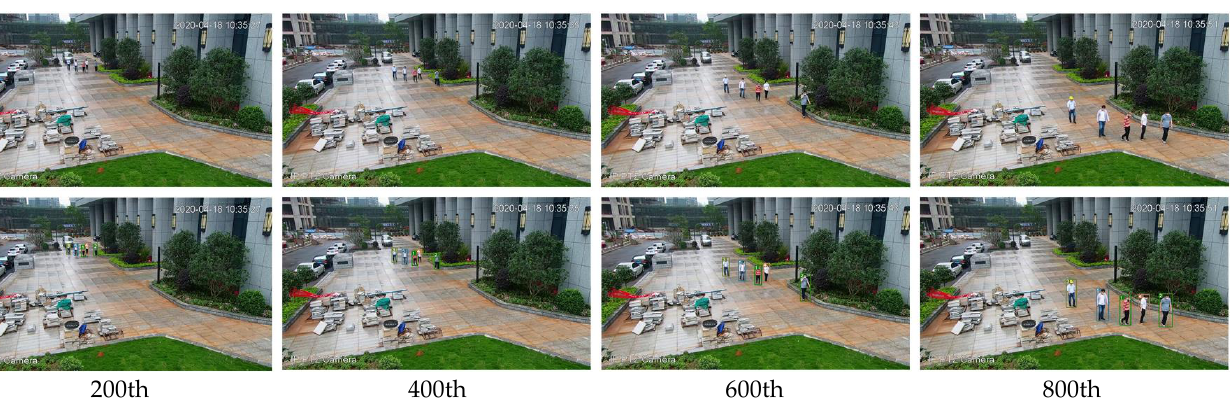
Figure 7. The corresponding frame of the original video and the tracking video. From left to right, the five images in the first row are the 200th, 400th, 600th and 800th frames of the original video. The five images in row 2 are the 200th, 400th, 600th, and 800th frames of the tracking video.